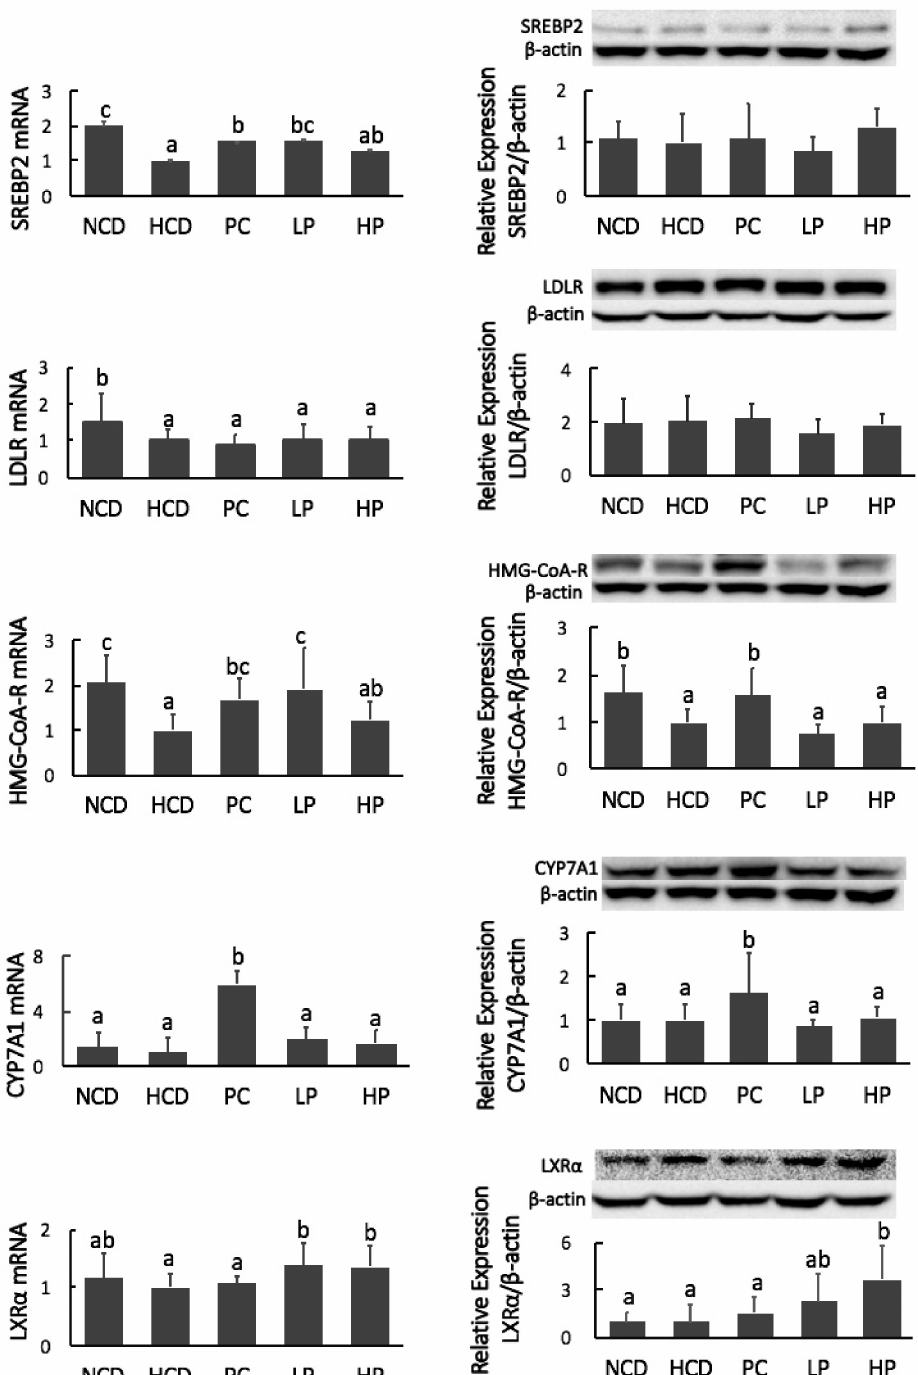
Figure 9. mRNA levels and protein mass of hepatic sterol regulatory element-binding protein-2 (SREBP2), low-density lipoprotein receptor (LDL-R), 3-hydroxy-3-methylglutary-CoA reductase (HMG-CoA-R), cholesterol-7a-hydroxylase (CYP7A1) and liver X receptor alpha (LXR α ) in hamsters fed one of five diets: NCD, no cholesterol diet; HCD, high cholesterol diet containing 0.1% cholesterol; PC, high cholesterol diet containing 0.5% cholestyramine; LP, high cholesterol diet containing a low dose (0.1%) soybean germ phytosterols (SGP); HP, high cholesterol diet containing a high dose (0.2%) of soybean germ phytosterols (SGP). n = 8 for each group. a,b,c = means with di ff erent superscript letters di ff er significantly at p <